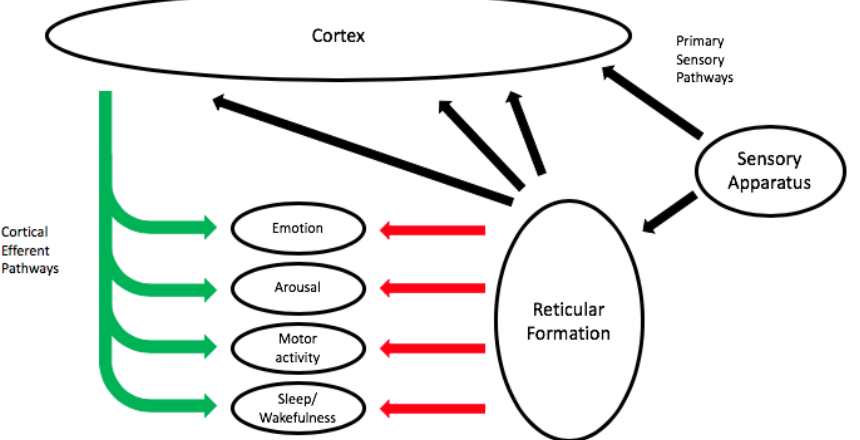
Figure 5. Schematic diagram of the reticular activating system including links between the sensory systems, the reticular formation, the cortex, and systems mediating physiology/behaviors that are activated by the reticular formation but are also under efferent control from the cortex.